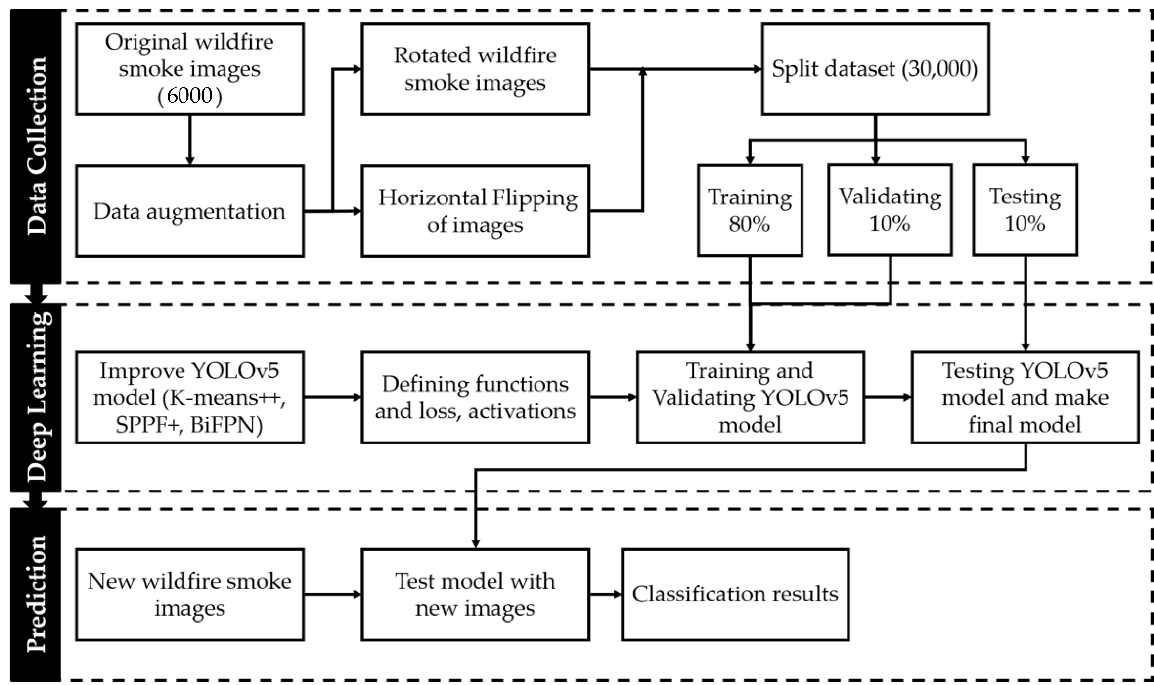
Figure 2. The flow chart of the proposed method.